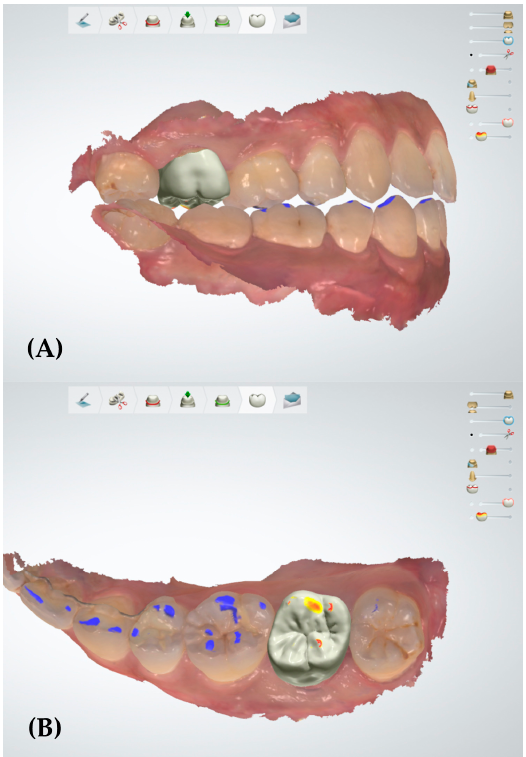
Figure 3. Adjustment with Patient Specific Motion for the PSM group. ( A ) In the running recorded articulation mode, the recorded dynamic occlusion was visually reproduced in the CAD software. ( B ) After running the recorded articulation, the red and yellow colors were marked in the crown design, and the marked areas were removed in the CAD